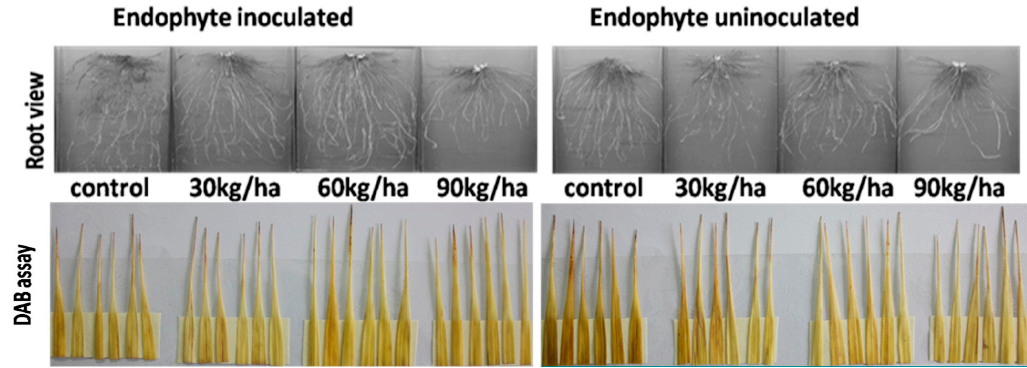
O activity in fully 2 2